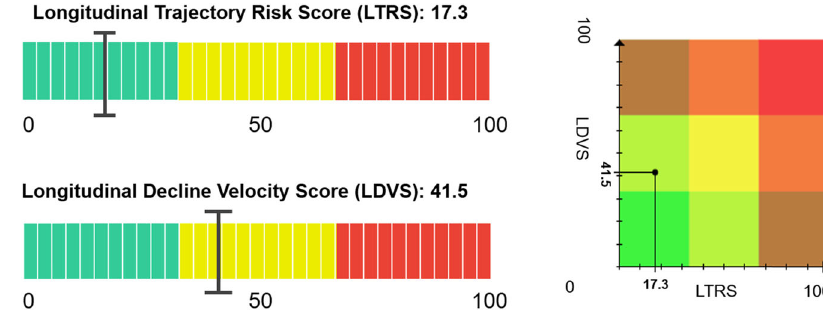
Fig. 6 Illustrations of the LTRS (top) and LDVS (bottom) on the left (numbers 17.3 and 41.5 are random examples). The two measures can be used in a matrix to obtain a combined longitudinal risk matrix (right). Green indicates low risk, yellow medium, and red high risk. In the risk matrix (right), the overlapping areas allow for a more nuanced interpretation.